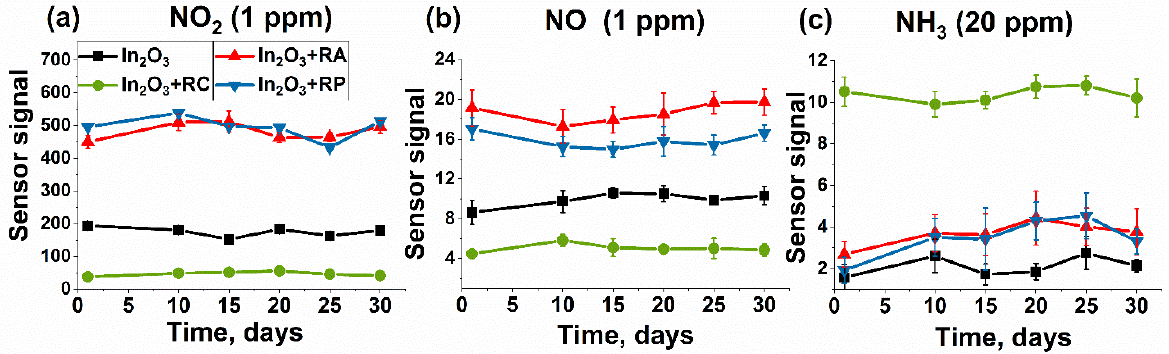
Figure 9. Stability of the sensors for 30 days toward 1 ppm NO 2 ( a ), 1 ppm NO ( b ), and 20 ppm NH 3 ( c ) at room temperature under periodic light illumination.